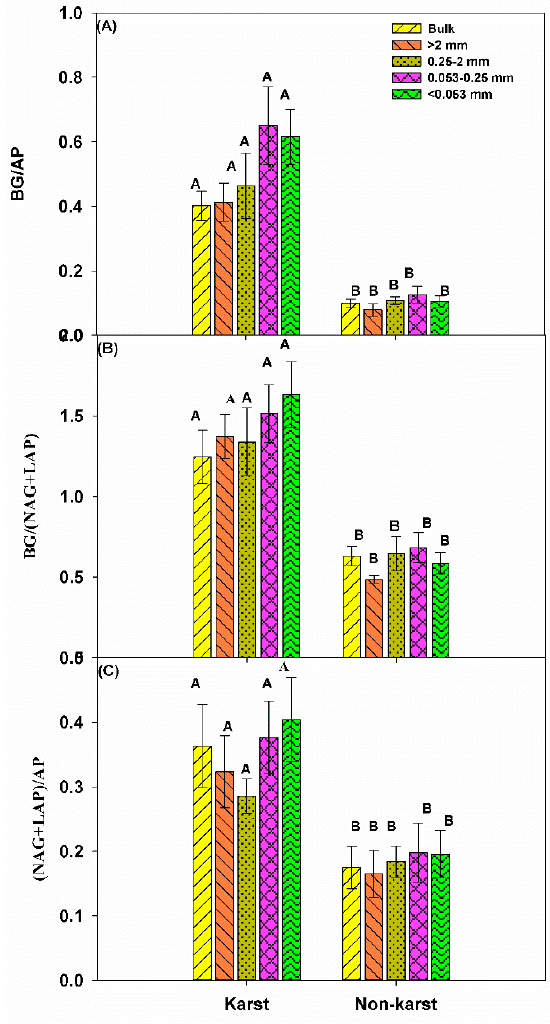
Figure 5. The proportion of enzyme activity associated with C, N, and P. BG, β - D -glucosidase. Error bars represent the standard deviation. Capital letters indicate differences among the forest ecosystem in the same aggregate size.